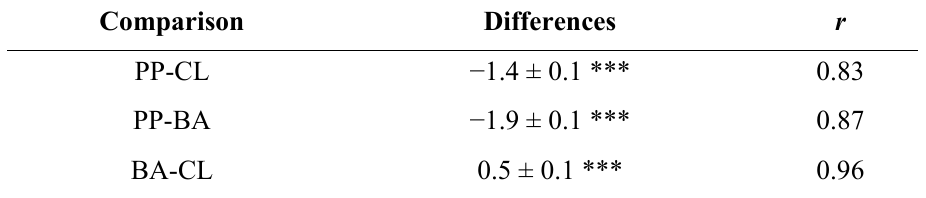
Table 4. Daytime (8 a.m.–6 p.m.) estimates of dead fine fuel moisture content (%) during the sequence of high fire danger days: differences (mean ± std. error) and correlations ( r ) within pairs of forest stands, with the significance of the Wilcoxon signed-rank test; n =